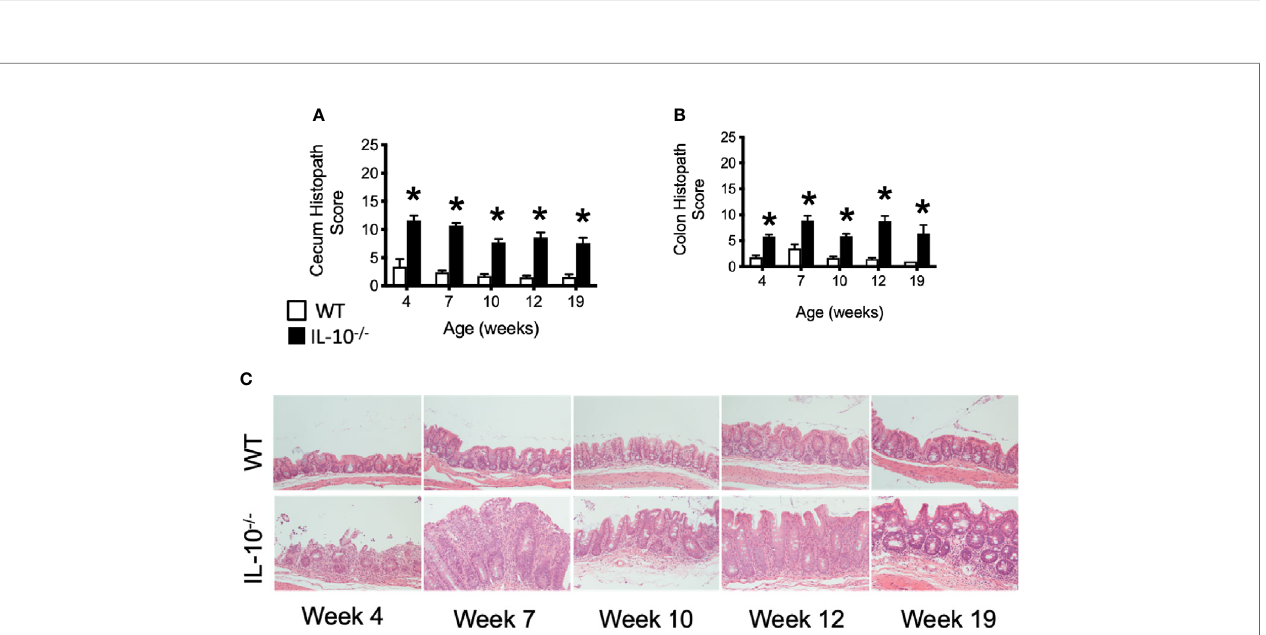
FIGURE 4 | Microscopic evaluation of GI tissue from WT and IL-10 -/- mice. Microscopic lesion scores for mice for the cecum (A) and colon (B) . Data are presented as mean ± standard error of the mean (SEM) and for statistical comparison, * = p ≤ 0.05 when comparing WT and IL-10 -/- mice at a given time point. See Materials and Methods for the criteria used to generate the lesion scores. (C) Representative photomicrographs of cecal tissue collected from WT and IL-10 -/- mice at different time points. Tissue samples were fi xed in 10% buffered formalin and routinely processed prior to staining with hematoxylin and eosin. All images were magni fi ed 200X. The number of mice used for each strain at each time point varied as follows: at 4 weeks of age, n = 5; at 7 weeks of age, n = 10; at 10 weeks of age, n = 9; at 12 weeks of age, n = 13; at 19 weeks of age, n =